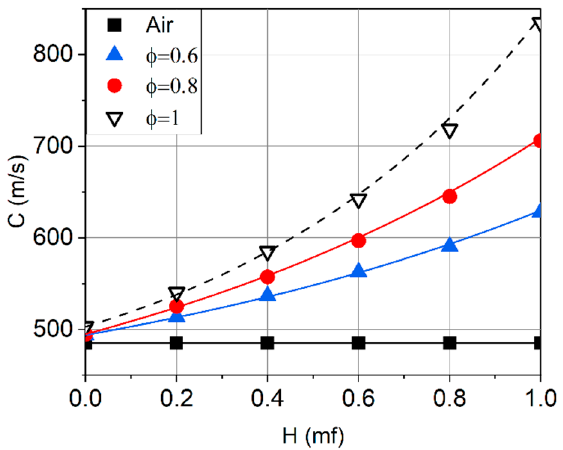
Figure 27. The influence of the molar fraction of hydrogen on the speed of sound.